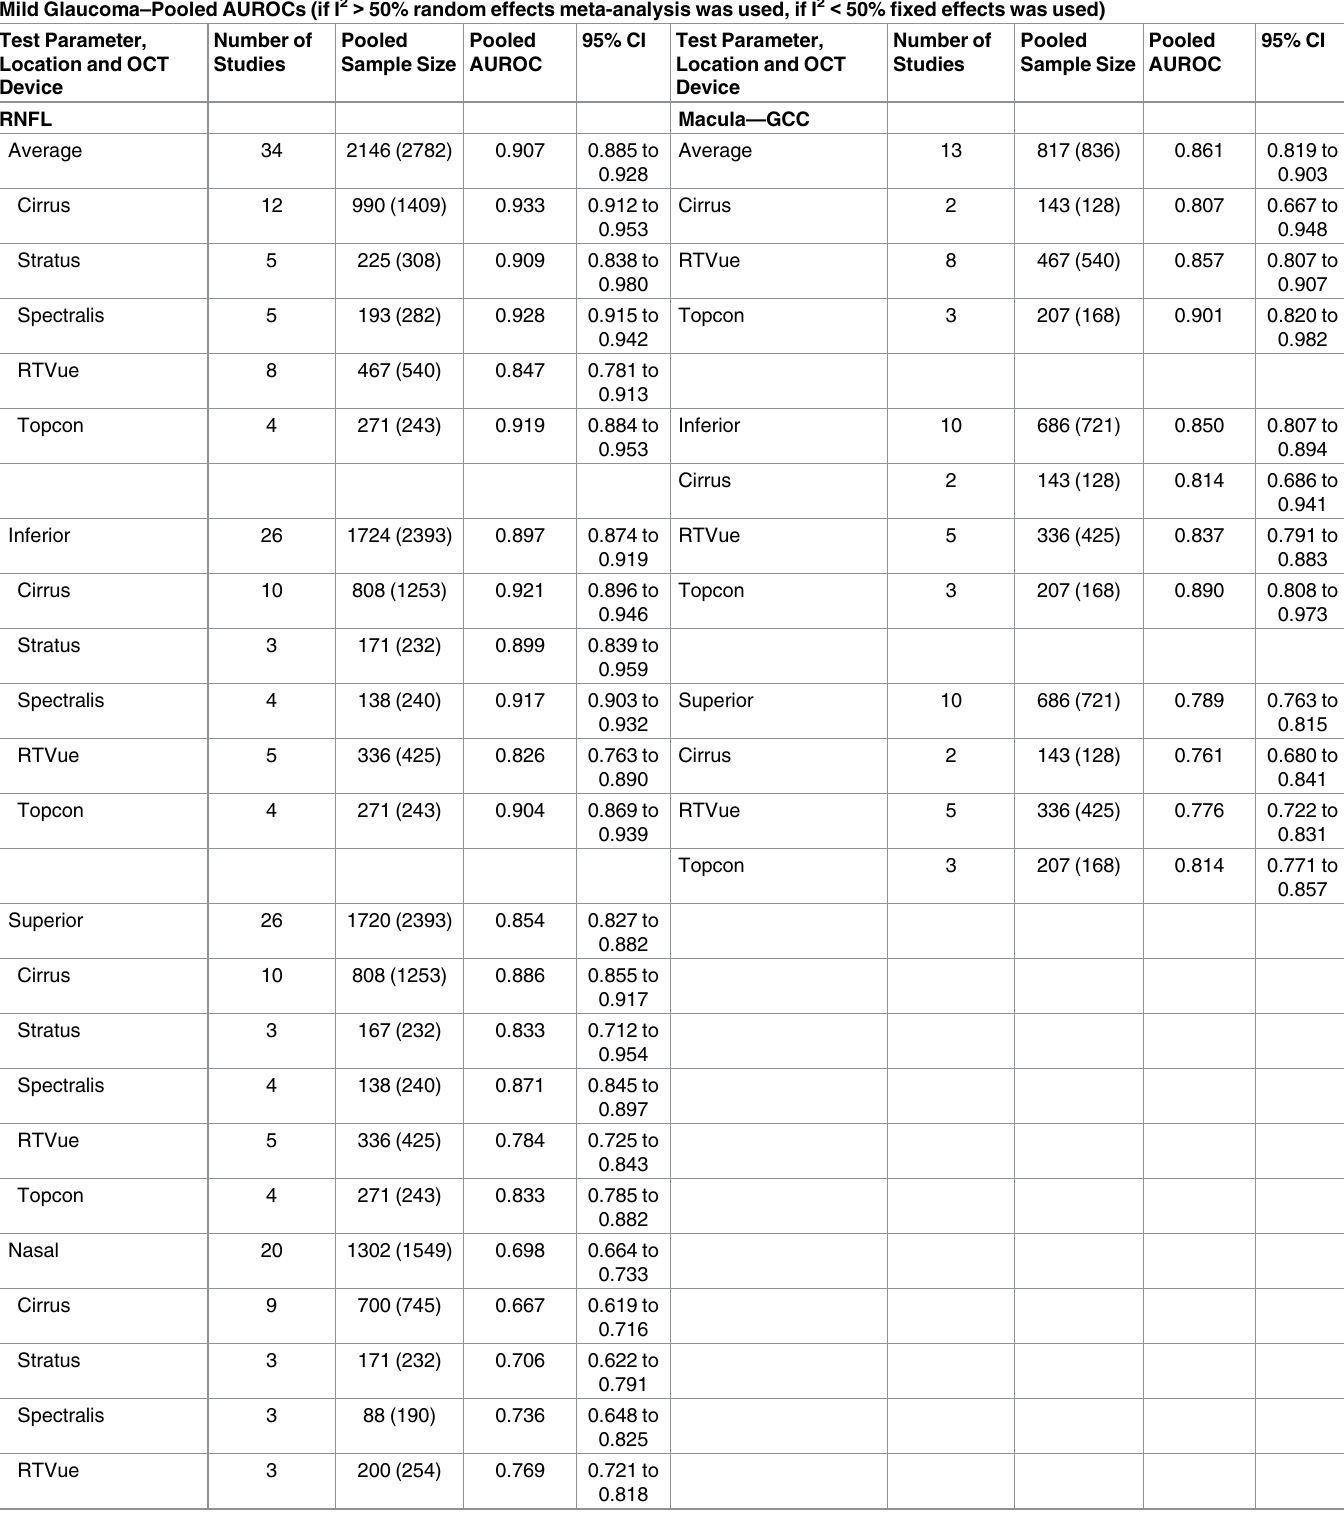
Table 5. Pooled AUROCs of RNFL and macular OCT parameters for mild glaucoma